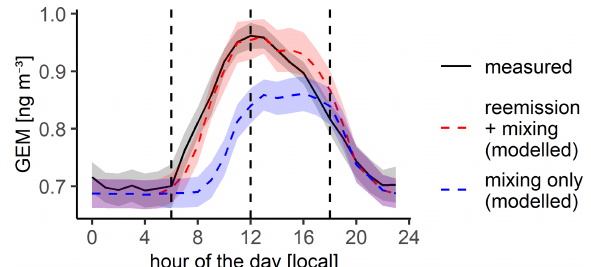
Figure 7. Assessment of the potential role of surface GEM reemis- sion as a driver for GEM diurnal cycles. The solid line shows the observed mean diurnal GEM cycle for those days characterized by an especially marked diurnal GEM variation (Group 1). The dashed lines give the corresponding modeled mean diurnal GEM cycles if (1) only mixing processes between MBL and LFT are considered (dashed blue line; assumed MBL GEM = 1.0ngm − 3 ) and (2) pa- rameterized photo-reemission from the island’s vegetated surface is added to the mixing model (dashed red line; assumed surface flux is a result of inverse modeling). Shaded areas show the arithmetic mean ± 2 times the standard